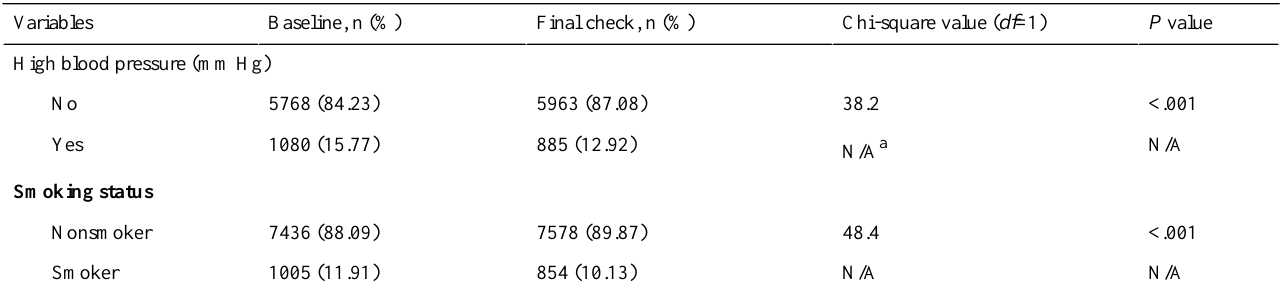
Table 5. Blood pressure and smoking status of SiSU users at baseline compared with final check